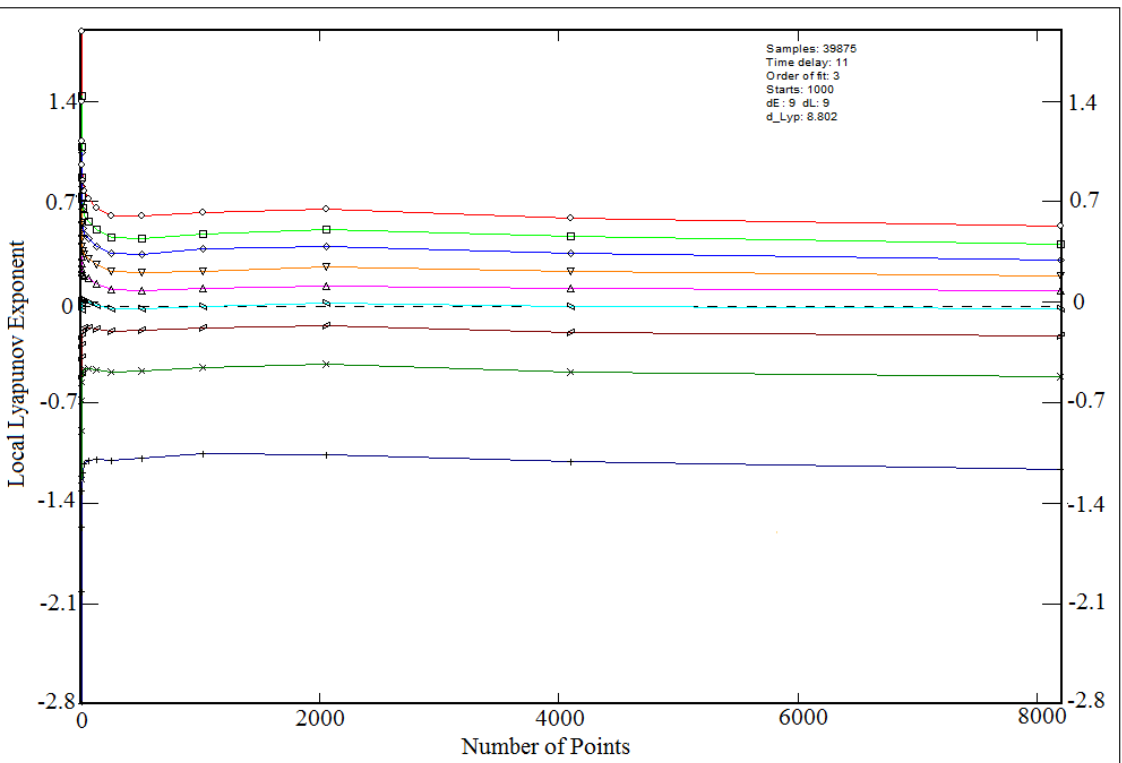
Figure 10. Local Lyapunov exponent when the follower offsets to the right (O = 10 mm) at cam speed (N = 200 rpm), coefficient of restitution (0.2), and follower guide’s clearance (16 mm).